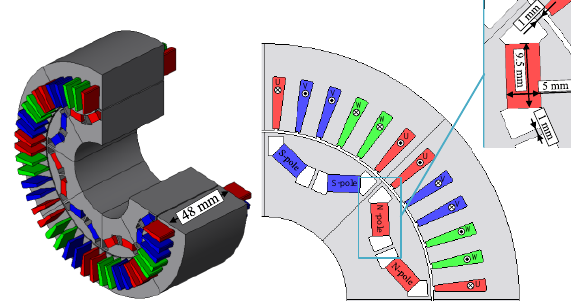
Figure 16. Analysis model of conventional IPM motor.